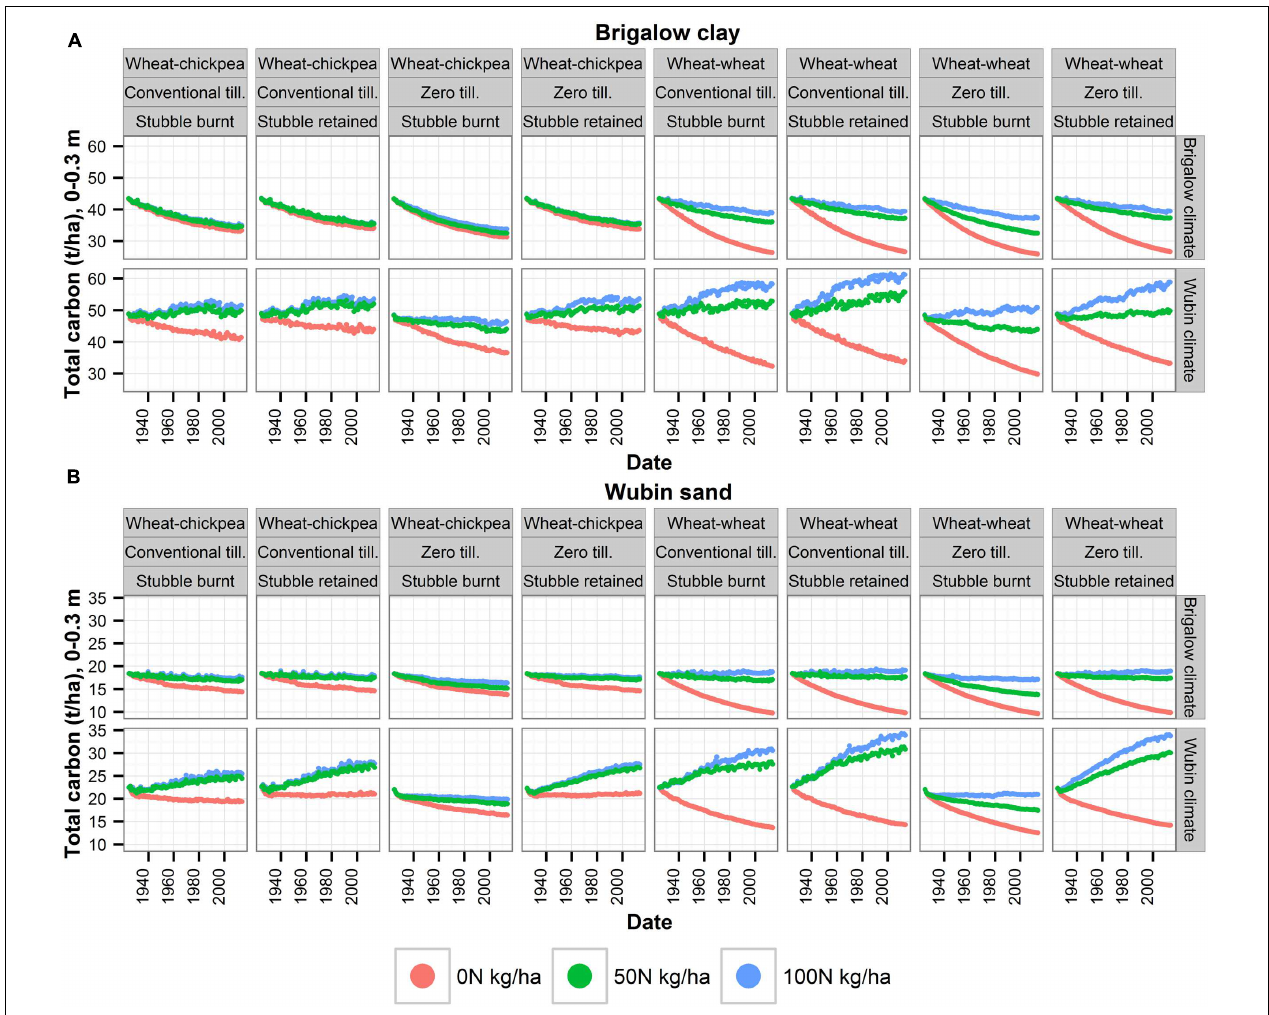
FIGURE 6 | Influence of soil, climate and different farming practices on SOC (0–0.3 m) over 90 years of APSIM simulations. (A) Brigalow clay, (B) Wubin